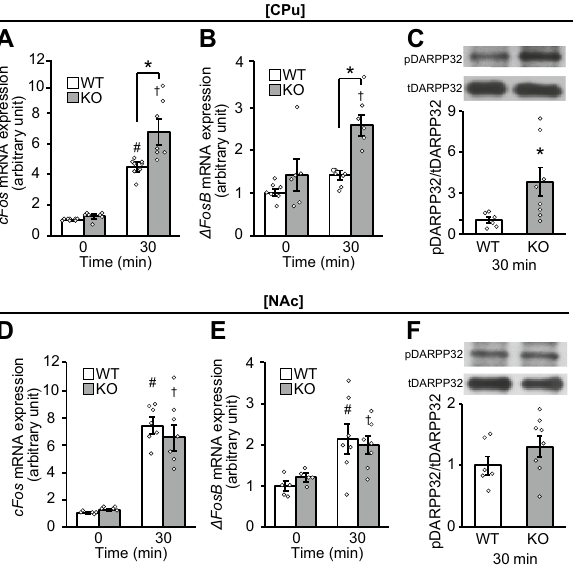
Figure 2. GABA B R deficiency in striatum neurons increases expression levels of cFos and ΔFosB mRNAs as well as phosphorylation of DARPP32 in CPu neurons. ( A – C ) The mRNA expression levels of cFos ( A ) and ΔFosB ( B ), and phosphorylation of dopamine- and cyclic-AMP–regulated phosphoprotein of molecular weight 32,000 (DARPP32) protein ( C ) in the caudate putamen (CPu) in wild-type (WT) and knockout (KO) mice of the binge group. ( D – F ) The mRNA expression level of cFos ( D ) and ΔFosB ( E ), and phosphorylation of DARPP32 ( F ) in the nucleus accumbens (NAc) in WT and KO mice of the binge group. All values are mean ± SEM. Statistical analyses were performed using two-way factorial analysis of variance (ANOVA) ( A , B , D and E ) followed by Sidak’s post-hoc test or unpaired t -test ( C and F ). # p < 0.05 versus 0 min in WT mice. † p < 0.05 versus 0 min in KO mice. * p < 0.05 versus WT mice. See also Supplemental Table 2 for details on